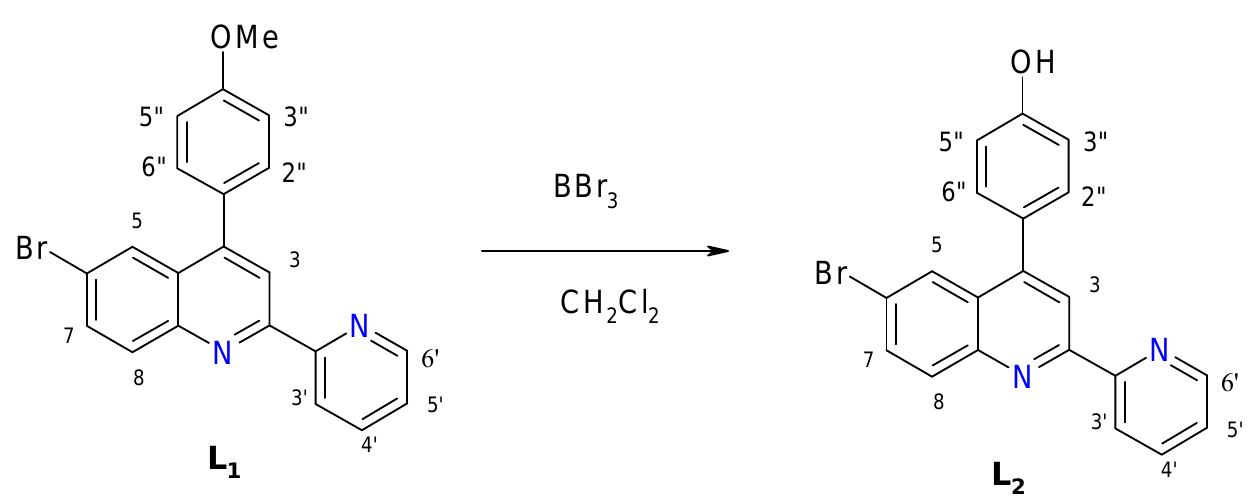
Table 1. 1 H-NMR spectral data for ligands L